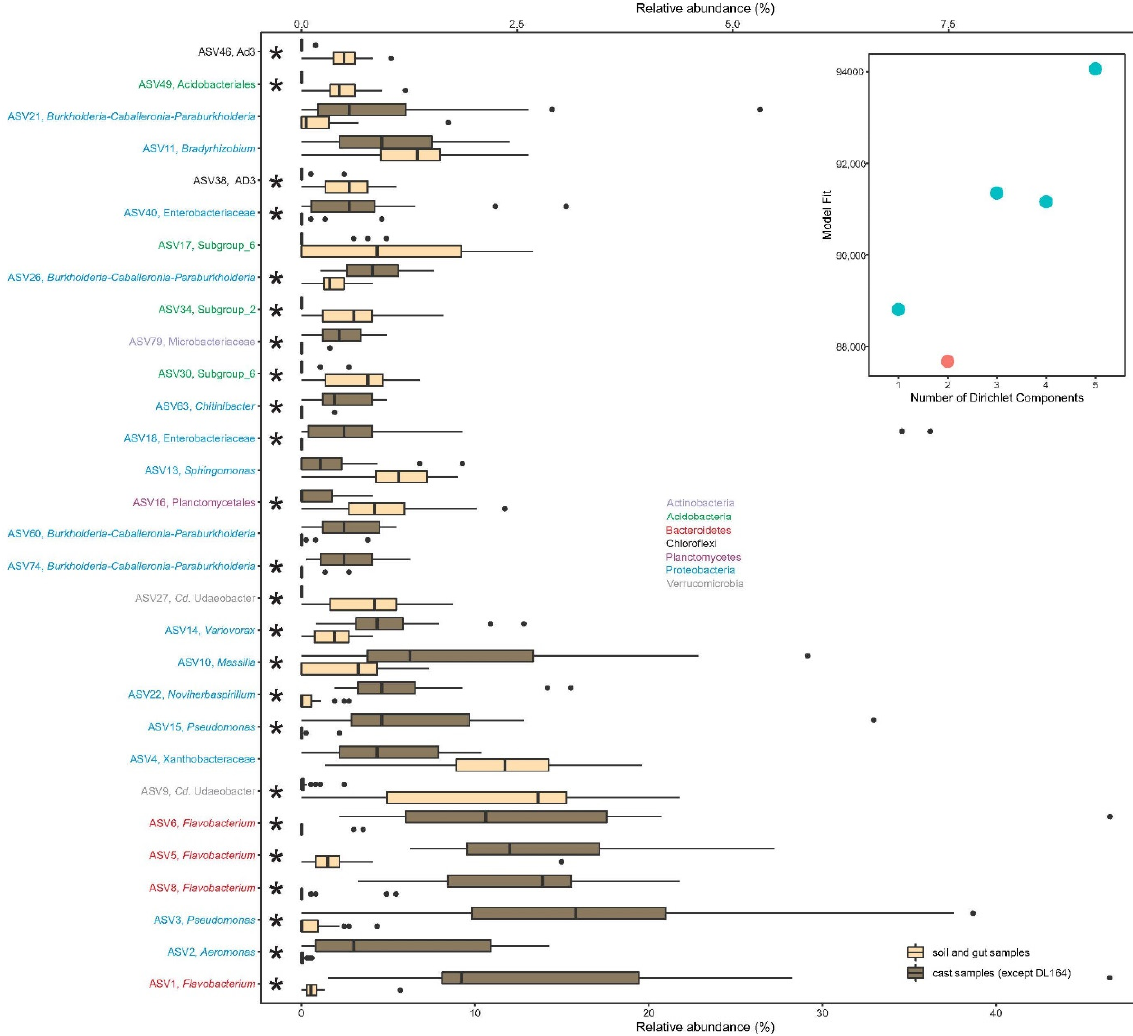
Figure 3. Relative abundance of the 30 most abundant ASVs in the samples assigned to each of the two metacommunity types found in transit of soil from gut to casts of the earthworm Aporrectodea caliginosa : metacommunity type 1 (Navajo white) corresponds to soil and gut, while metacommunity type 2 (dark brown) corresponds to cast samples. The insert represents the support for two metacommunity types when applying Dirichlet multinomial mixture models. ASVs are sorted in decreased order of importance from bottom to top. The lower X -axis represents ASV1 and ASV2 and the top X -axis the other ASVs. Asterisks indicate significant differences in ASV abundance between the two metacommunities analyzed with DESeq2. For each ASV we have included phylum (by color) and its most inclusive taxonomic classification.